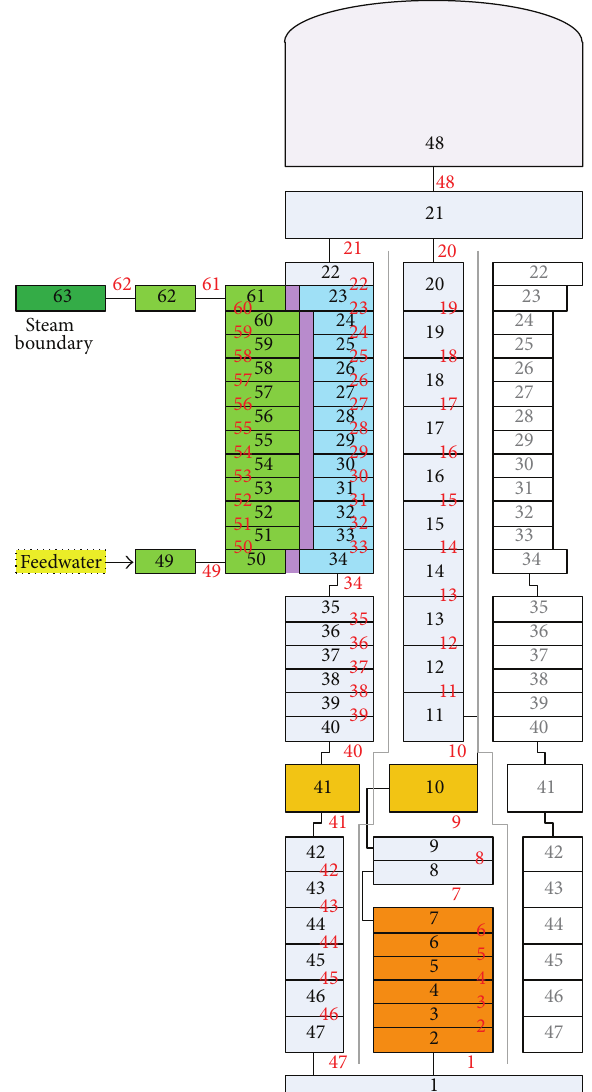
Figure 3: Nodalization of OSU-MASLWR